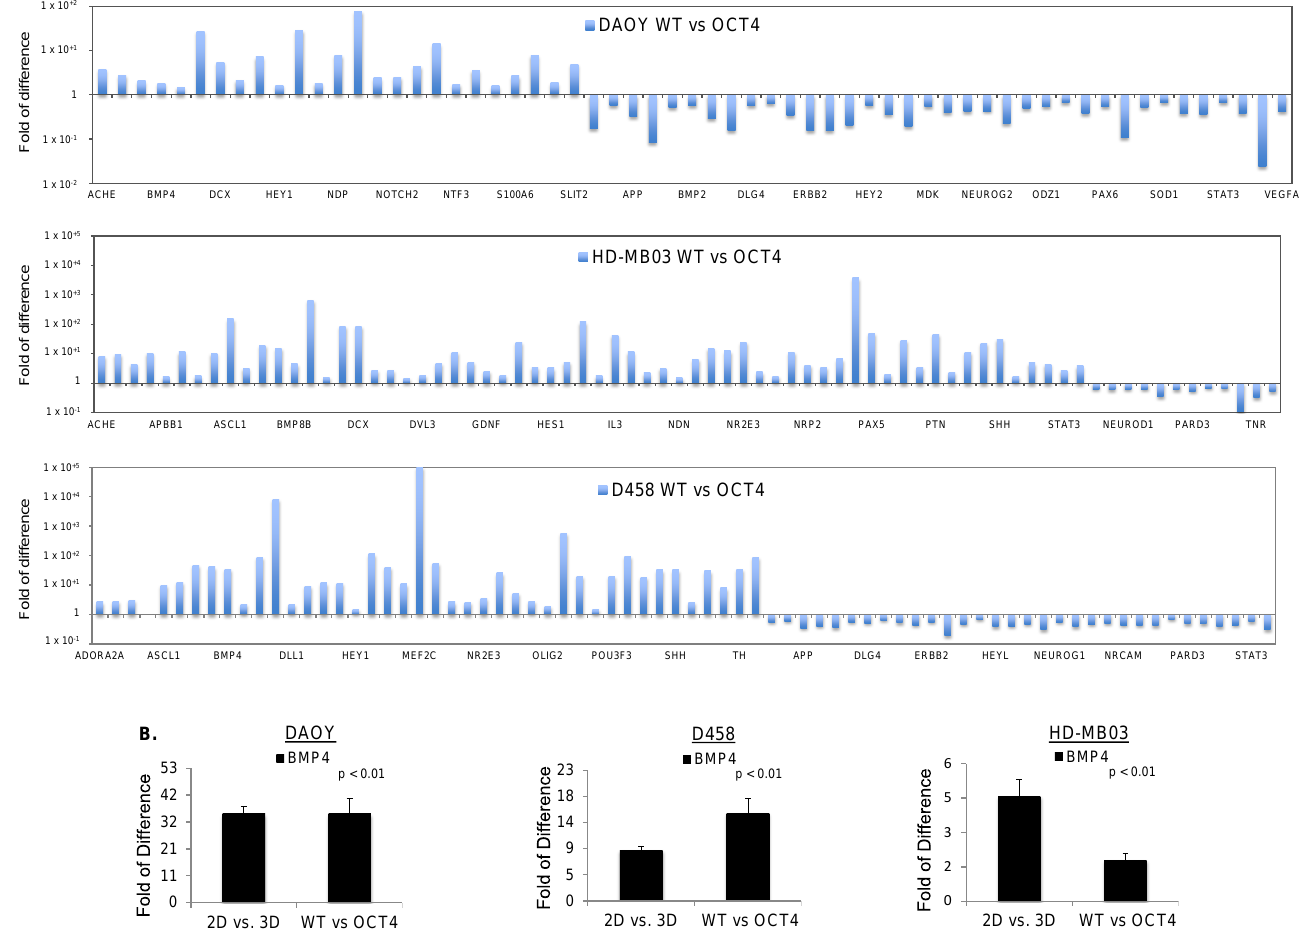
Figure 4. OCT4A over-expression induces BMP4 signaling in MB cells. ( A ) RT2 profiler PCR arrays performed in DAOY, HD-MB03, and D458 cells showing the expression level of differentially regulated genes in OCT4-overexpressing (OCT4) cells related to parental counterpart (WT) cells and normalized to the expression of housekeeping gene ACTB. ( B ) RT2 profiler PCR arrays of BMP4 level performed in OCT4-overexpressing DAOY, HD-MB03, and D458 cells related to parental counterpart (WT) cells and normalized to the expression of housekeeping gene